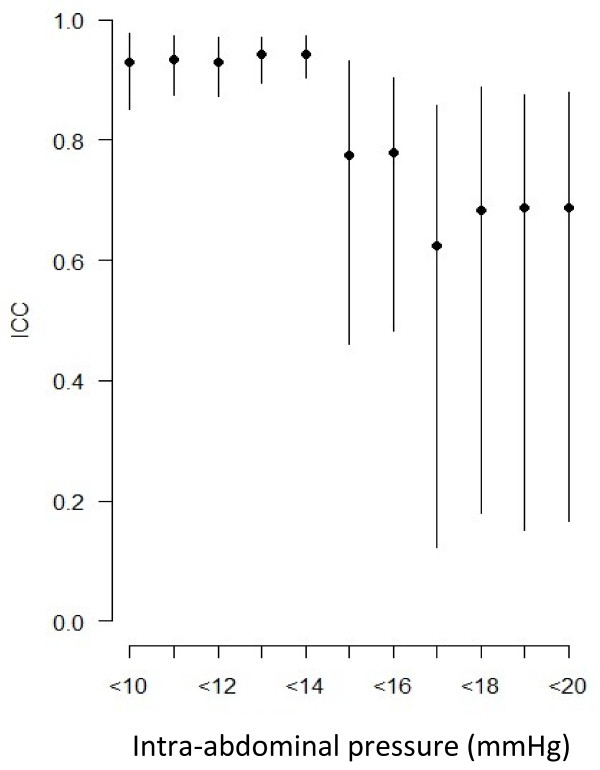
Intraclass correlation coefficient (ICC) for patients with intra-abdominal pressure less than a given value (dots for ICC values and lines for 95% confidence interval). When patients with high intra-abdominal pressure were added, ICC decreased.